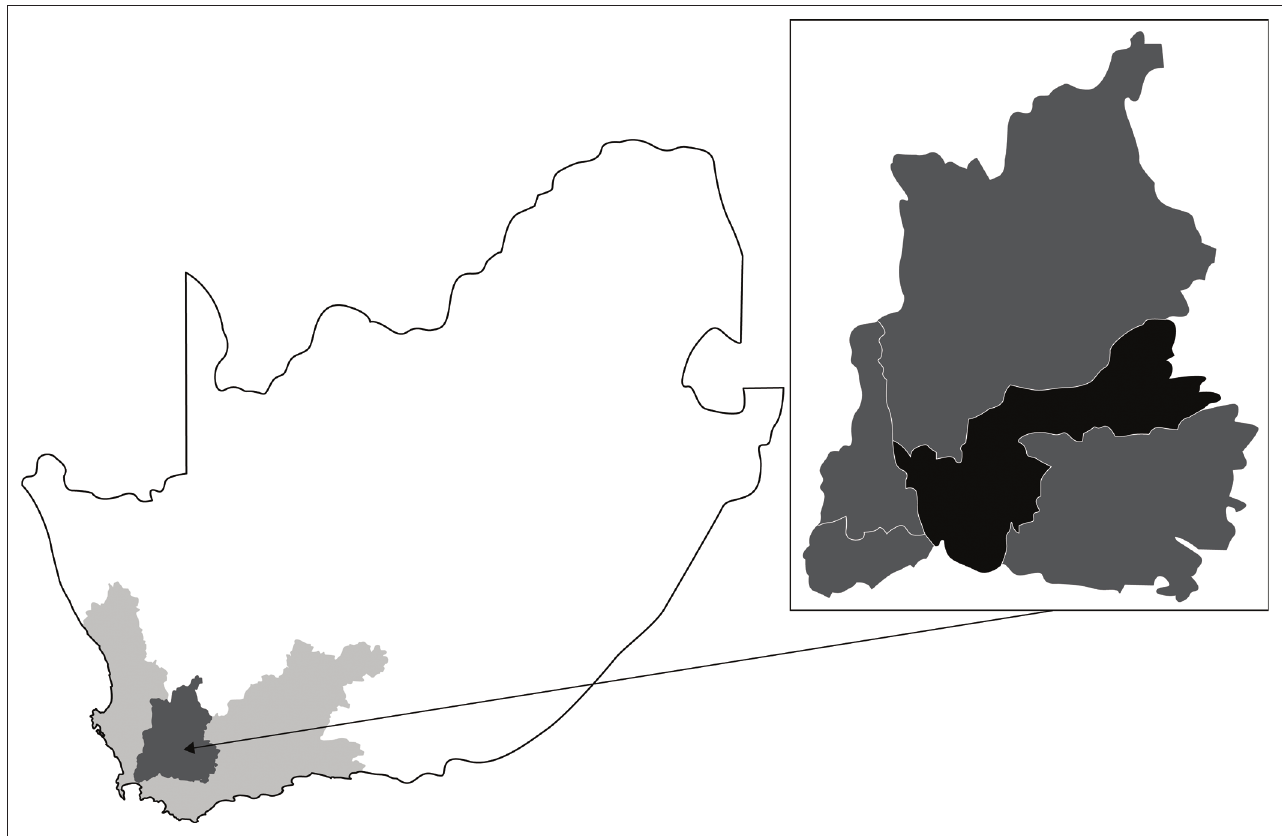
FIGURE 1: Map of South Africa illustrating the Western Cape province (light grey area), with the Cape Winelands district (darker grey area). The insert shows the Breede Valley subdistrict